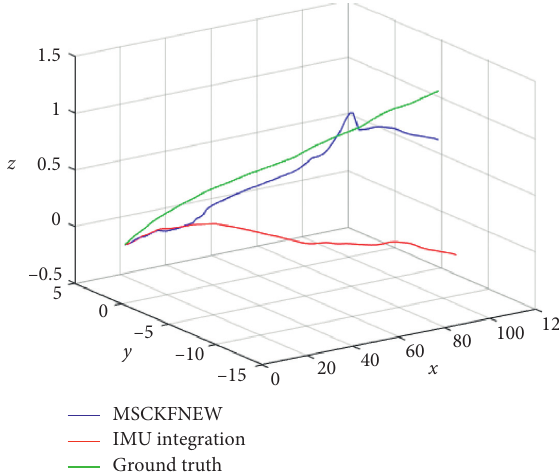
Figure 2: The trajectories by novel MSCKF algorithm with No.1